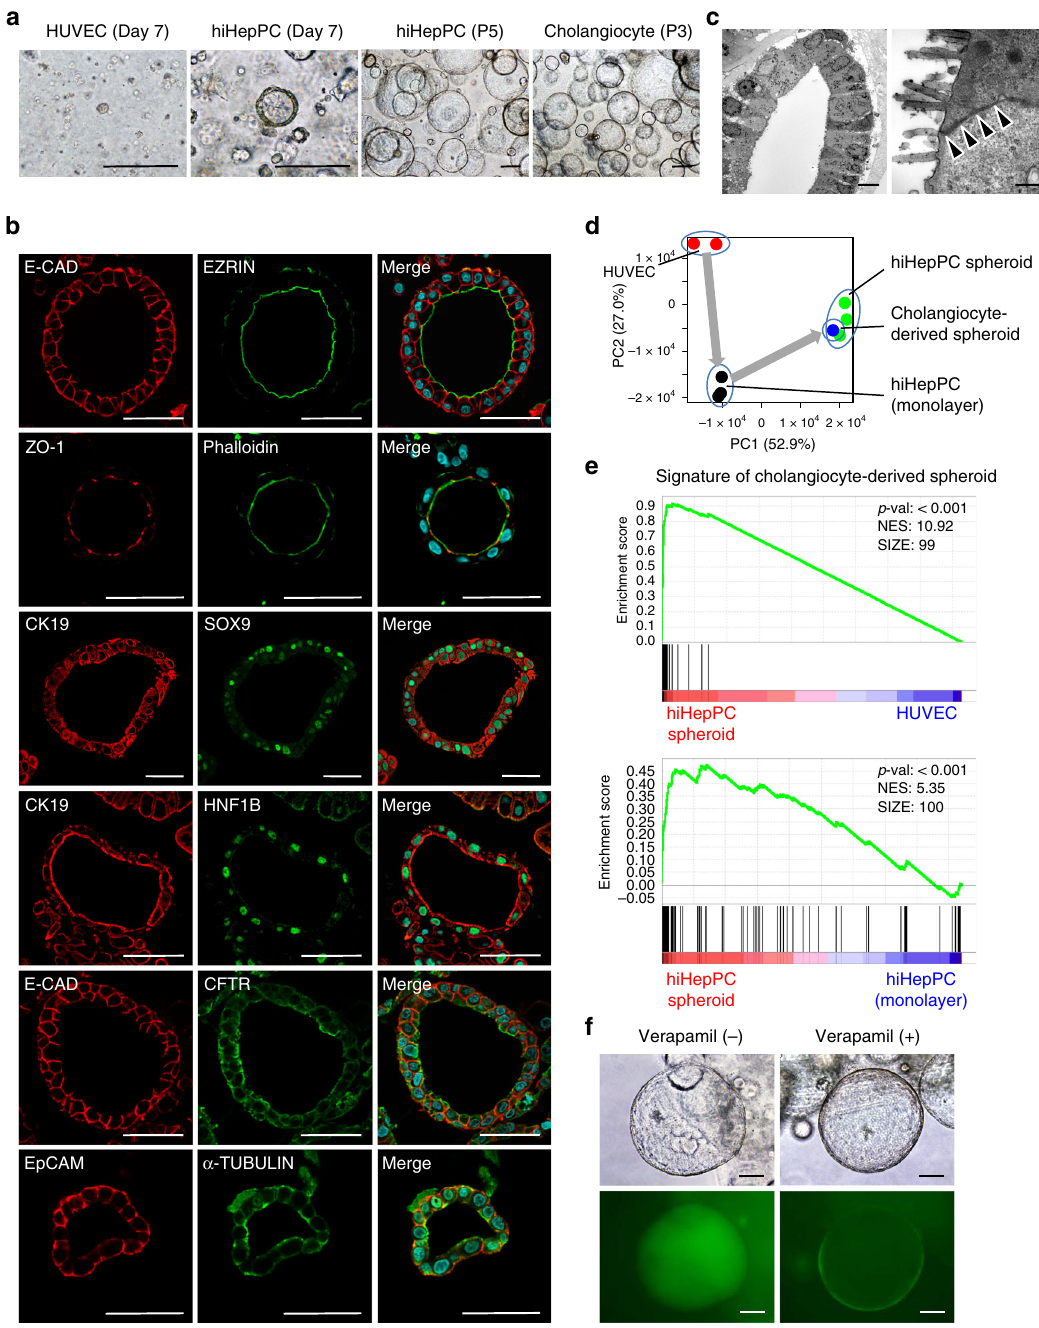
Fig. 4 Cystic spheroid formation from hiHepPC-derived cholangiocytes. a Representative images of 3D cultures of HUVECs and hiHepPCs at day 7 and passage (P) 5 and those of adult human liver-derived cholangiocytes at P3 after initiation of 3D culture with Matrigel. Scale bars, 100 µ m. b Co- immuno fl uorescence staining of E-CAD with EZRIN or CFTR, of CK19 with SOX9 or HNF1B, and of EpCAM with α -TUBULIN and immuno fl uorescence staining of ZO-1 with phalloidin staining of F-actin were conducted for hiHepPC spheroids. DNA was stained with DAPI. Scale bars, 50 µ m. c Representative ultrastructural images of hiHepPC spheroids ( n = 10 spheroids). Black arrowheads indicate intracellular tight junctional complexes. Scale bars, 10 µ m (left panel) and 500 nm (right panel). d PCA was performed using CEL-seq2 data for HUVECs, hiHepPC monolayer cultures, hiHepPC spheroids, and human fetal cholangiocyte-derived spheroids. e GSEA of CEL-seq2 data for hiHepPC spheroids and HUVECs and of those for hiHepPC spheroids and hiHepPC monolayer cultures were performed using the set of top 100 genes speci fi cally upregulated in human fetal cholangiocyte-derived spheroids. f Representative bright- fi eld and fl uorescence images showing uptake of rhodamine 123 (green) into the luminal space of hiHepPC spheroids and inhibition of rhodamine 123 transport after treating the spheroids with verapamil before the addition of rhodamine 123. Scale bars, 50 µ